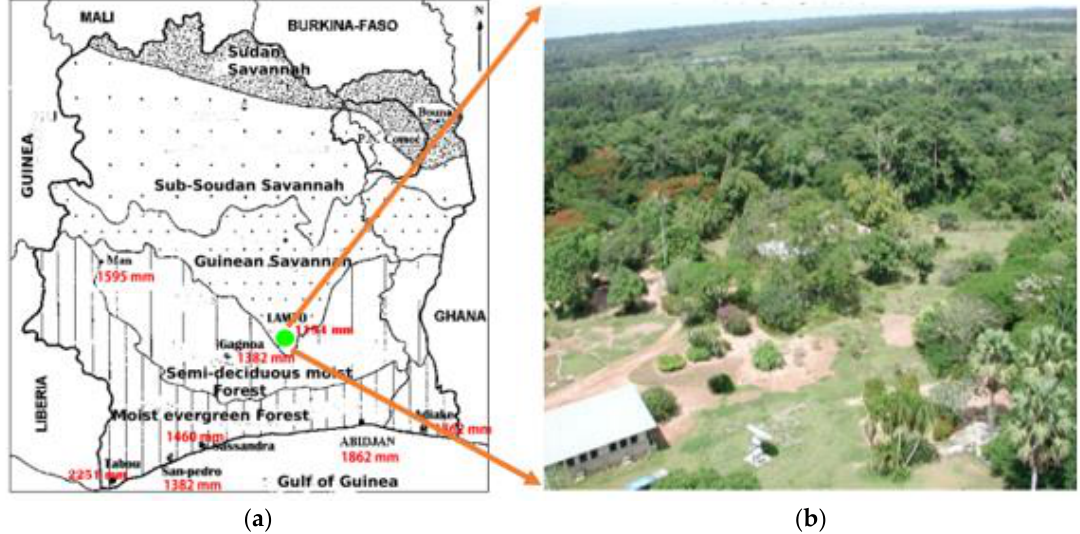
Figure 1. ( a ) Localization map of the Lamto-Côte d’Ivoire region (6°31′ N–5°02′ W). Green point indicates Lamto location; Numbers in red are the mean annual precipitation (1962–1997) of some synoptic stations and from north to south are located the types of vegetation (From Tiemoko et al. [36]). ( b ) Zoom on the vegetation of Lamto.